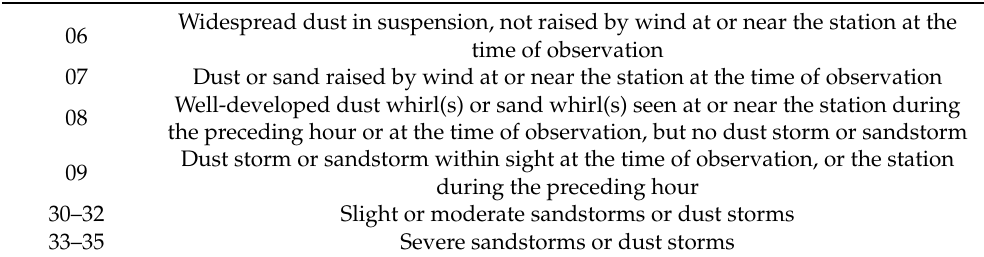
Table 1. The dust-related present weather codes. Widespread dust in suspension, not raised by wind at or near the station at the time of observation